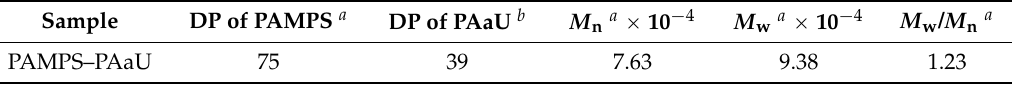
Table 1. Degrees of polymerization (DP) of PAMPS and PAaU blocks, number and